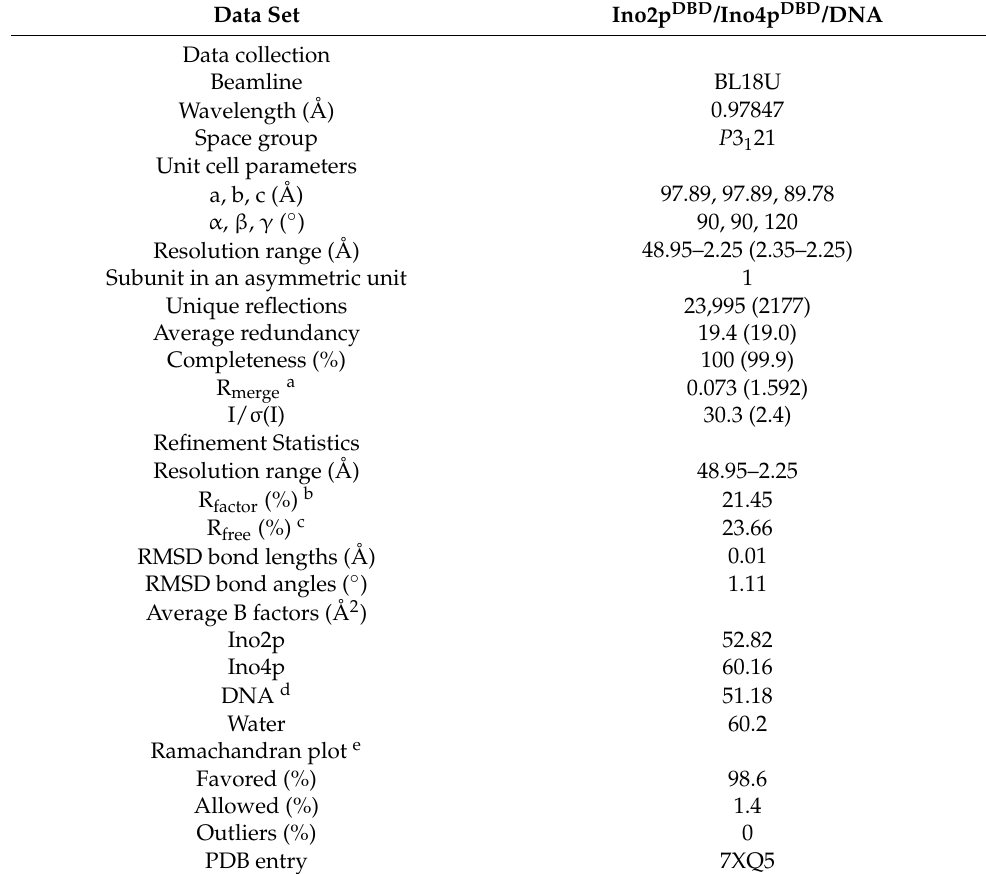
Table 1. Data collection and refinement